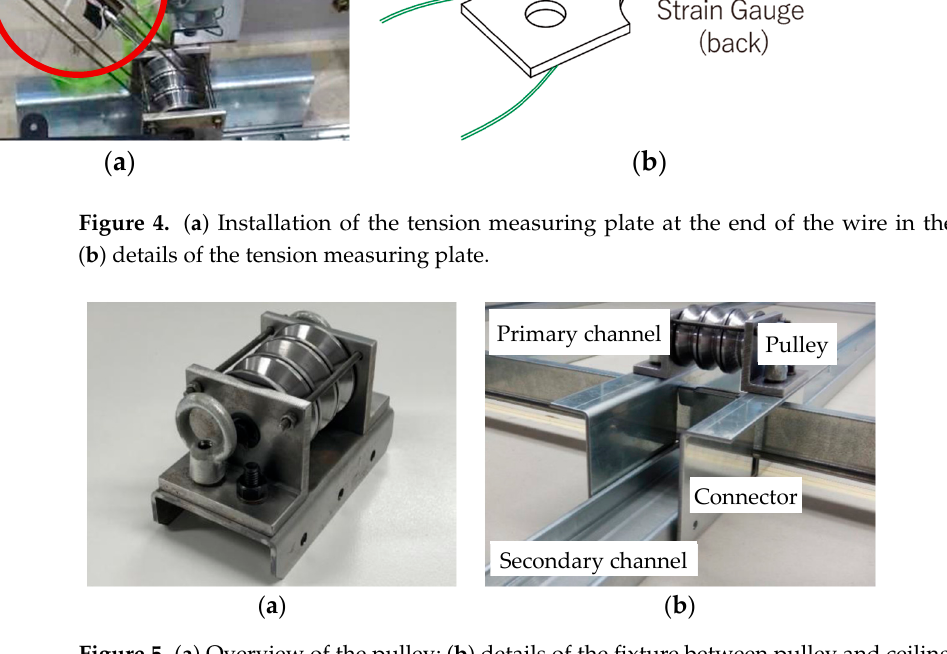
Figure 5. ( a ) Overview of the pulley; ( b ) details of the fixture between pulley and ceiling runners.